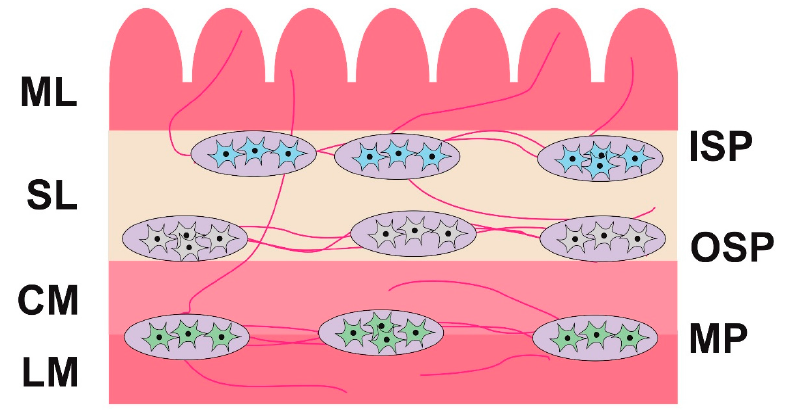
longitudinal muscle layer; CM—circular muscle layer; SL—submucosal layer; ML—mucosal layer. Parts of the enteric nervous system: MP—myenteric plexus; OSP—outer submucous plexus; ISP— inner submucous plexus.